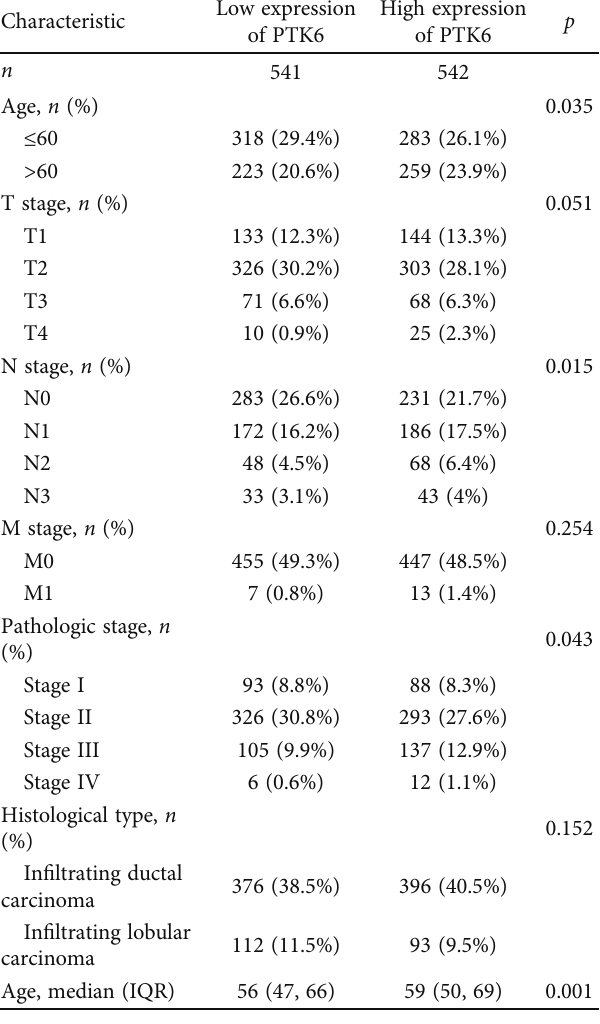
Table 1: The association between PTK6 expression and characteristics of patients su ff ering from BC.